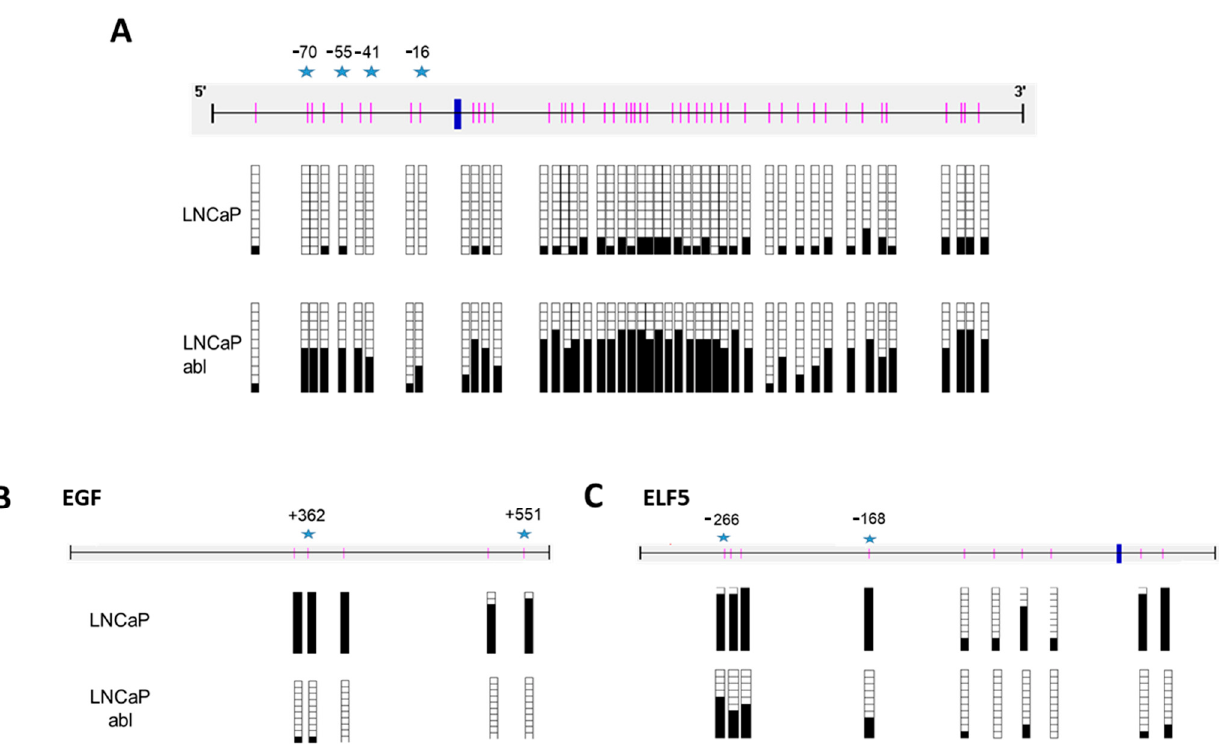
Figure 2. Analysis of CLDN3 ( A ), EGF ( B ), and ELF ( C ) methylation status in LNCaP and LNCaP abl cell lines. Schematic depiction of the CLDN3 ( A ), EGF ( B ), and ELF ( C ) promoter region around the corresponding transcription start site (thick blue vertical line). CpG dinucleotides are represented as short vertical lines. Results of bisulfite genomic sequencing of 10 individual colonies are shown. Presence of a methylated or unmethylated cytosine is indicated by a black or white square, respectively. Blue stars represent the CpGs analyzed in the array.